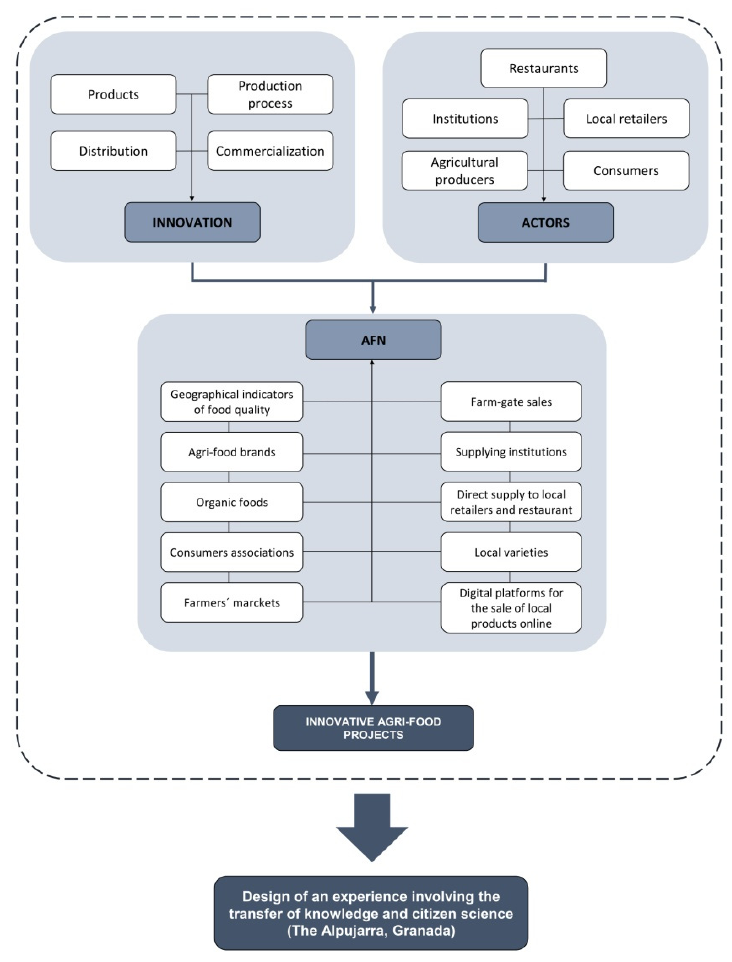
Figure 3. Conceptual framework for the research.